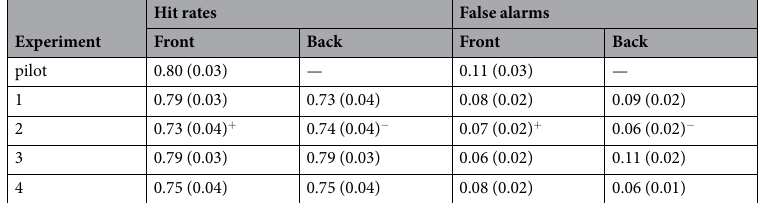
Hit rates False alarms Experiment Front Back Front